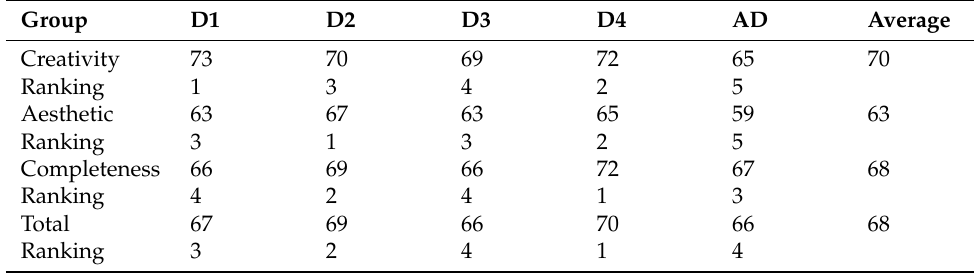
Table 3. Scores of Depression Groups’